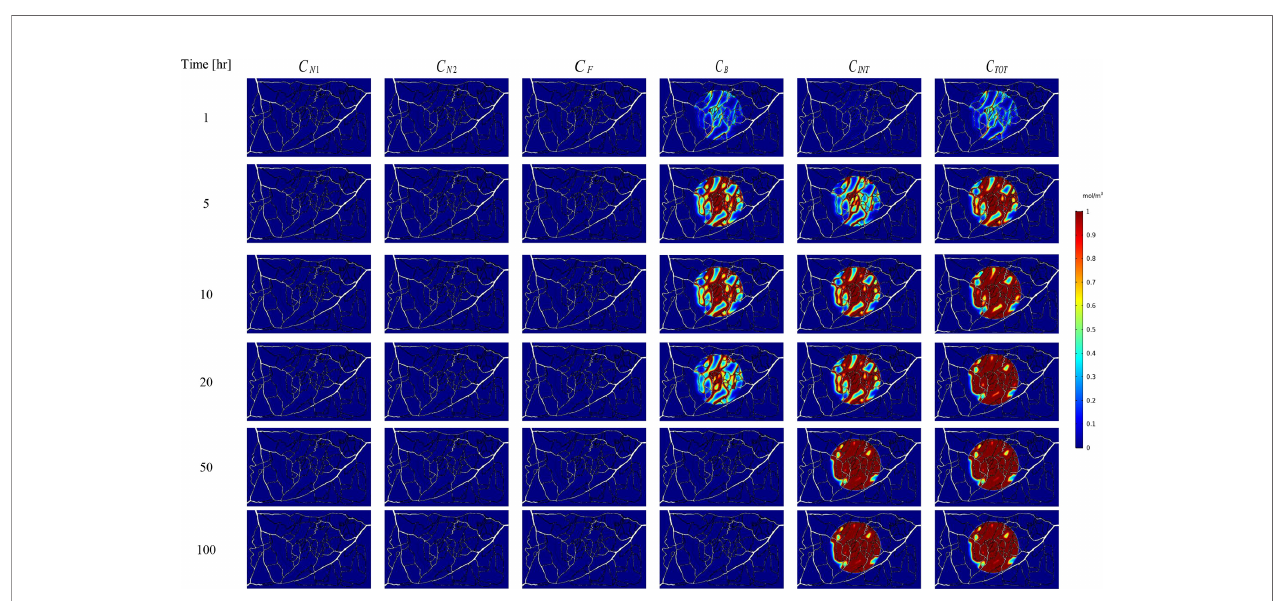
FIGURE 7 | Spatiotemporal distributions of concentrations of three-stage NPs in tumor and its surrounding normal tissue with increasing time.